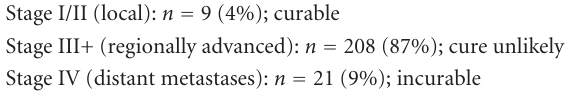
Table 1: 238 consecutive new cases of breast cancer from 2007-2008